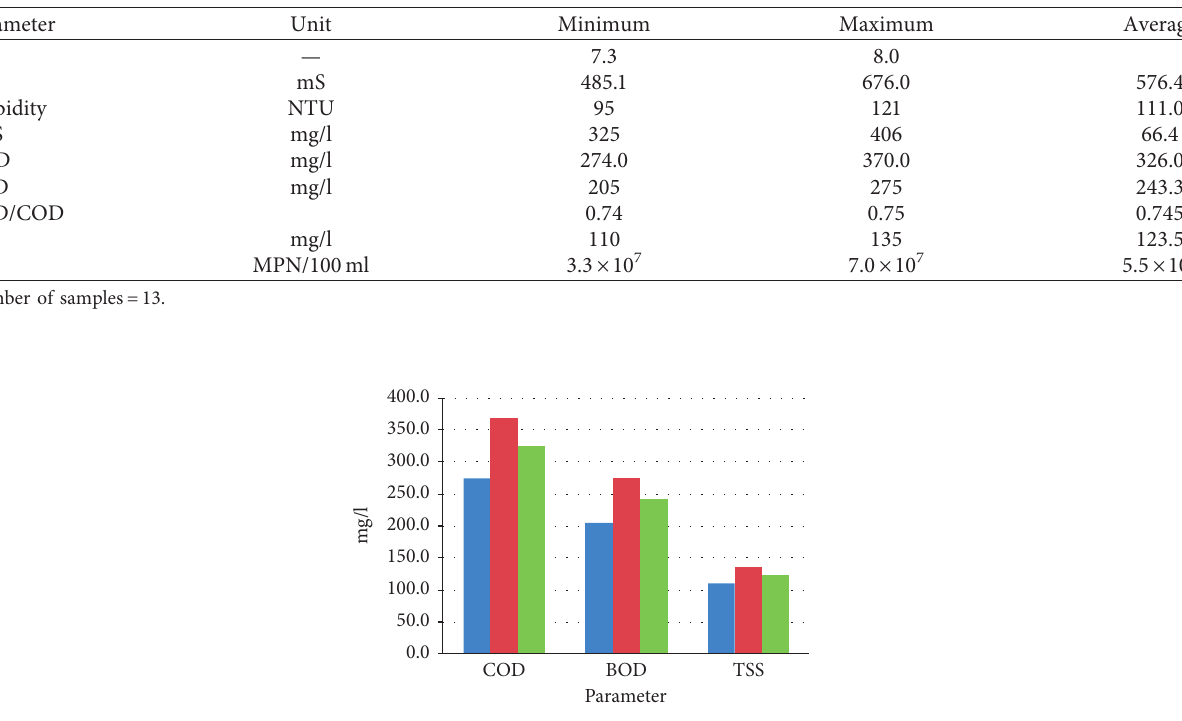
Table 2: Physicochemical features of the wastewater ∗ .